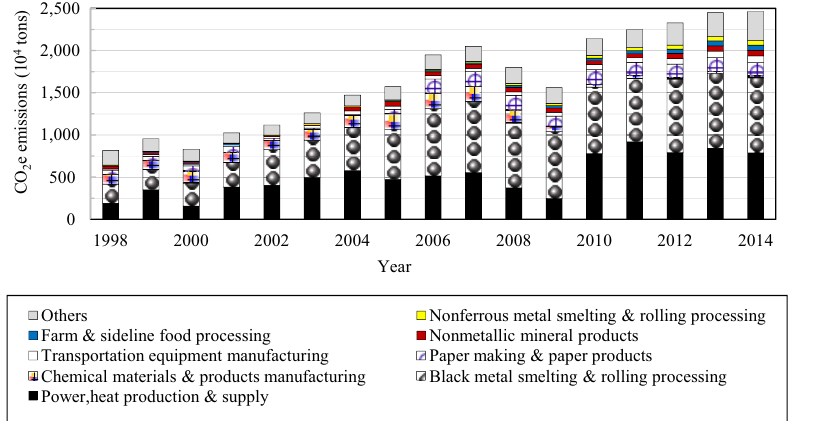
Figure 2. Accumulative results for the energy consumption CEs from all industrial